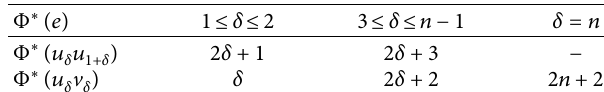
Table 10: Edge labeling of Φ ∗ ( e ) .